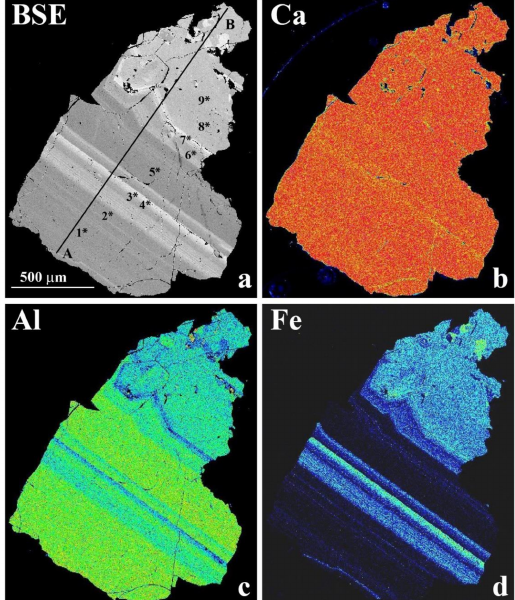
Figure 6. ( a ) Backscattered electron (BSE) image and elemental maps for sample-4 from Chihuahua-p, Mexico, showing ( b ) Ca content, ( c ) Al content, and ( d ) Fe content. Two separate phases may be deduced from the elemental maps, but such phases are most easily detected by HRPXRD (Figure 11). The intergrowths of two phases have contact boundaries that are parallel to northwest. Cations from the points marked 1 to 9 in ( a ) are shown in Figure 7b. A line scan from A to B in ( a ) across the crystal is provided (Figure